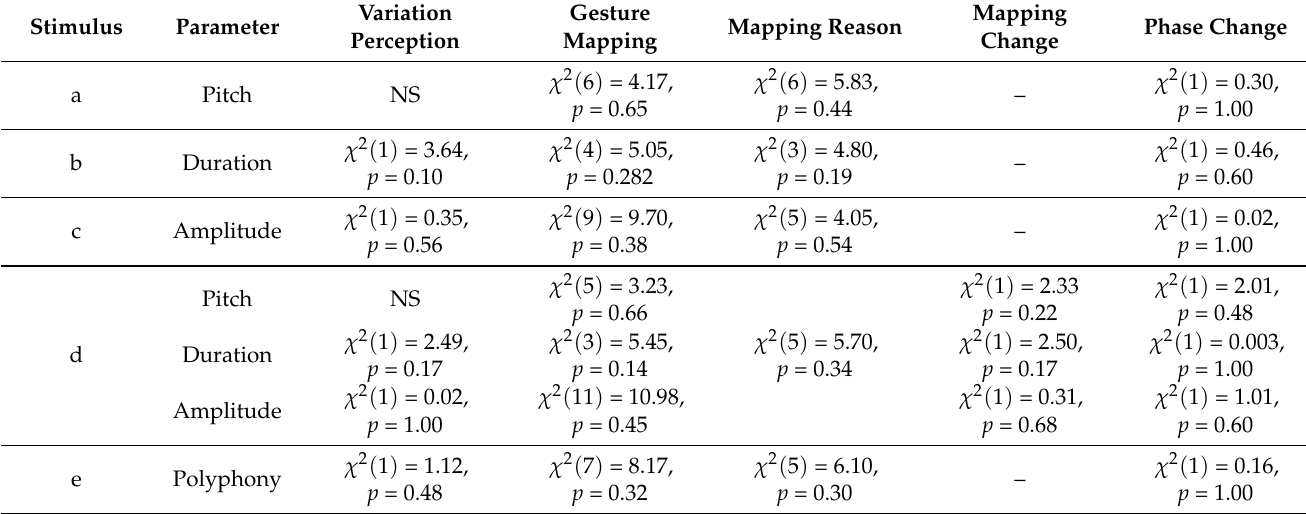
Table A28. Phase 2 profile associations. NS: Value is